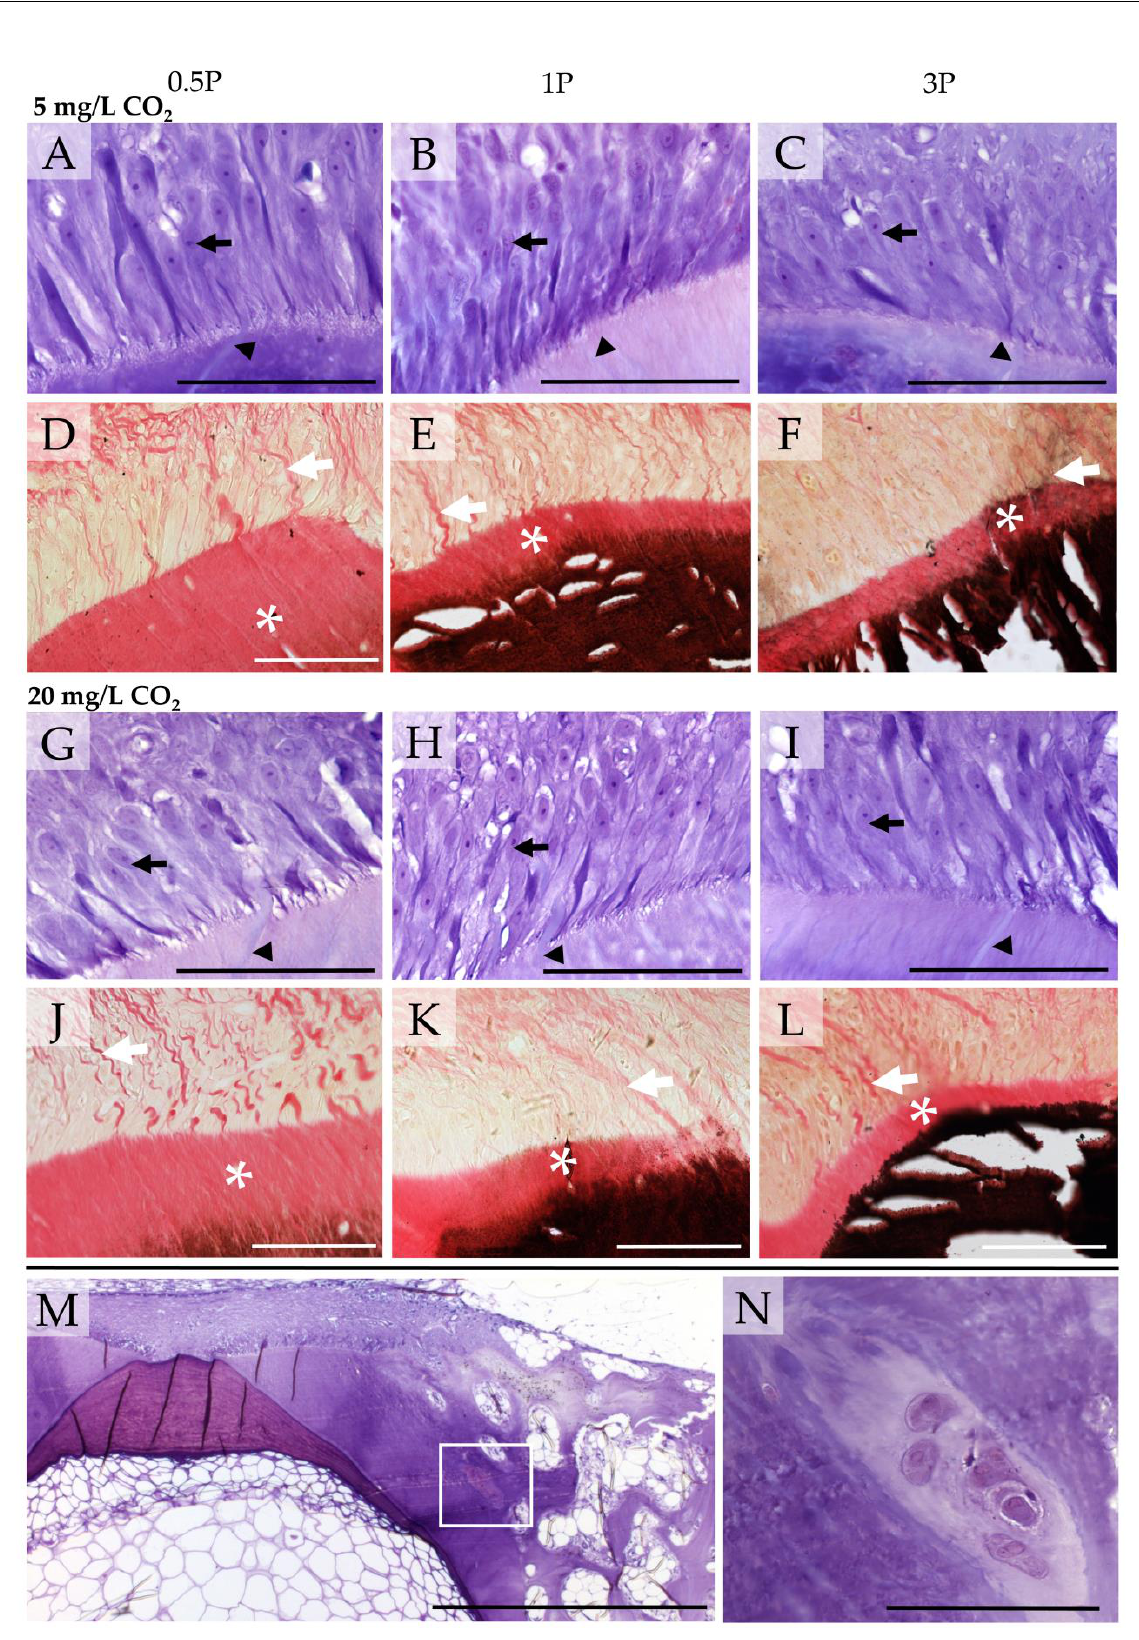
Figure 7. Morphology of vertebral bodies. ( A – C , G – I ) Demineralized parasagittal sections show a detailed depiction of active spindle-shaped osteoblasts (black arrows) and Sharpey’s fibers (black arrowheads) in representative samples of Atlantic salmon at week 16 fed different levels of a total phosphorus (P) 0.5P (6.3 g/kg), 1P (9.0), and 3P (26.8 g/kg) and reared in conditions with no CO